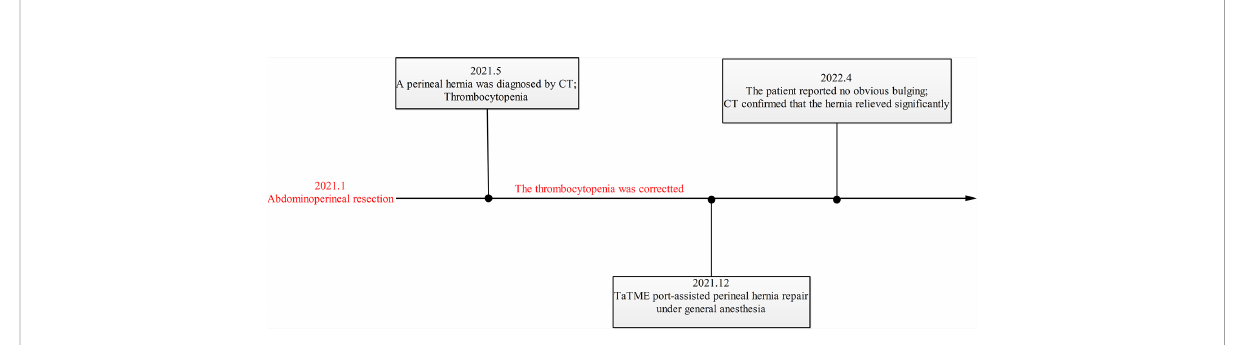
FIGURE 8 The timeline of this case.